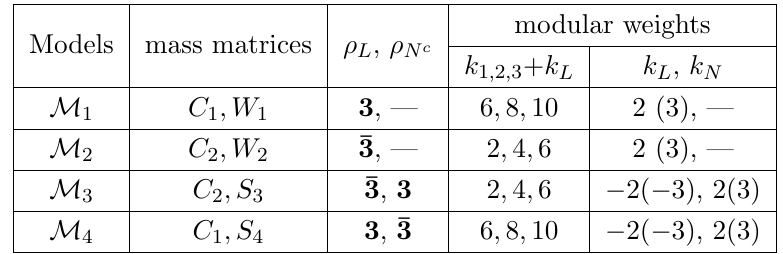
Figure 2 . The allowed values of the e(cid:11)ective Majorana neutrino mass m (cid:12)(cid:12) with respect to the lightest neutrino mass m 1 in the model W 1 with k L = 3, where we consider the case of NO neutrino masses. The blue (green) dashed lines represent the most general allowed regions for IO (NO) where the neutrino oscillation parameters are varied within their 3 (cid:27) ranges [50]. The horizontal grey band denote the current experimental bound m (cid:12)(cid:12) < (120 (cid:0) 250) meV from KamLAND-Zen [52]. The vertical grey exclusion band denotes the bound on the lightest neutrino mass extracted from P m i < 120 meV by the Planck collaboration [53]. i